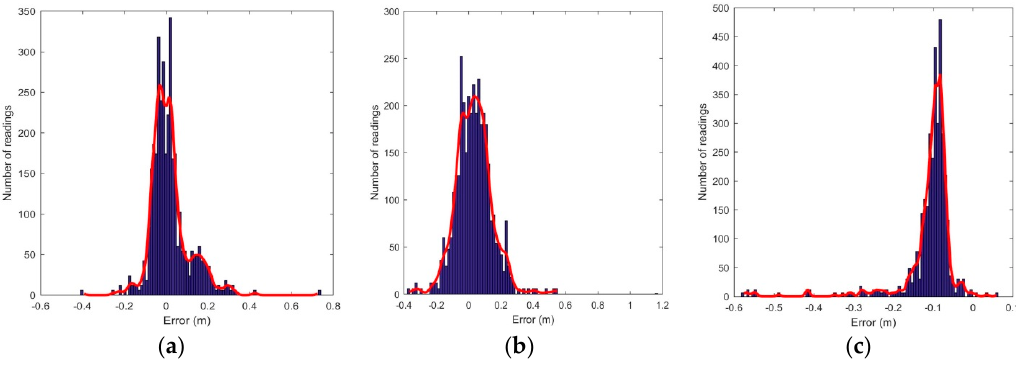
Figure 12. Errors in the measured receiver coordinates. ( a ) Error in X coordinates; ( b ) Error in Y coordinates; ( c ) Error in Z coordinates. Table 1. X , Y, and Z coordinates error statistics.